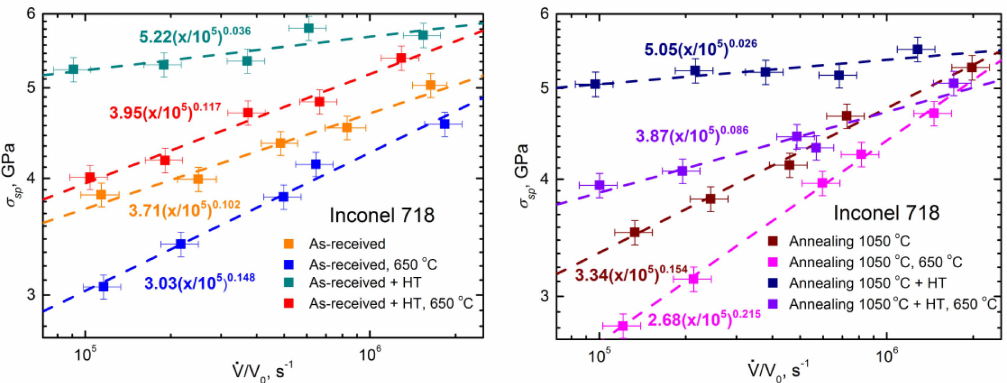
Figure 8. The effect of temperature on the spall strength of Inconel 718 superalloy samples subject- ed to various heat treatments.